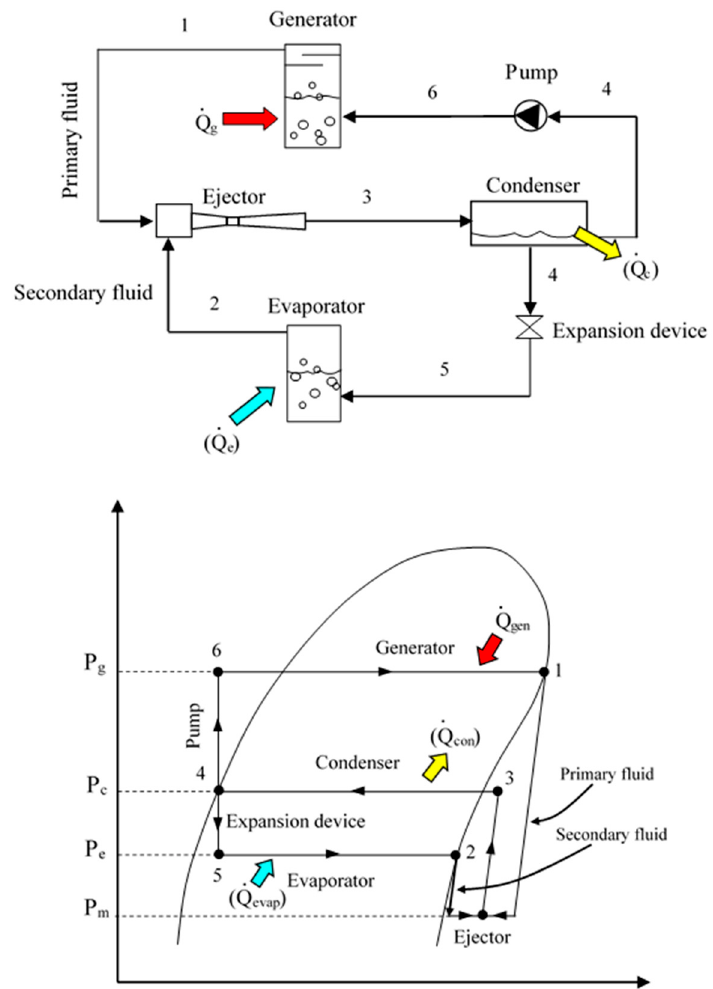
Figure 1. The ejector refrigeration cycle and its refrigerant flow state.